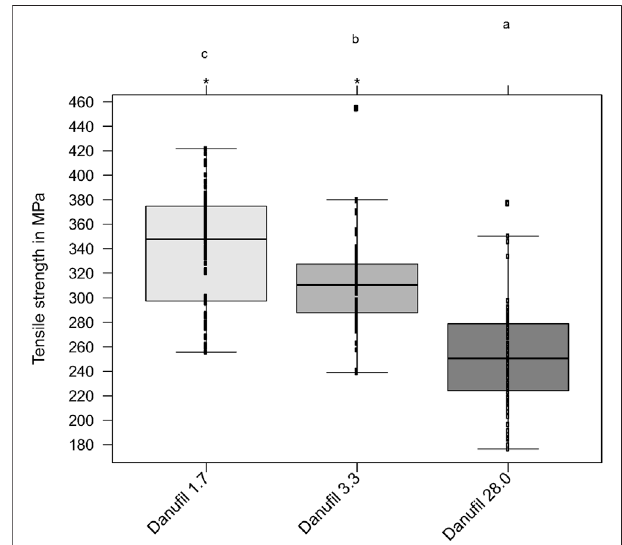
FIGURE4| TensilestrengthofDanu fi lviscose fi breshavinga fi nenessof 1.7, 3.3 and 28.0 dtex. Results are shown as Box-Whisker Plots. Different letters indicate signi fi cant differences, a * marks results which do not follow a normal